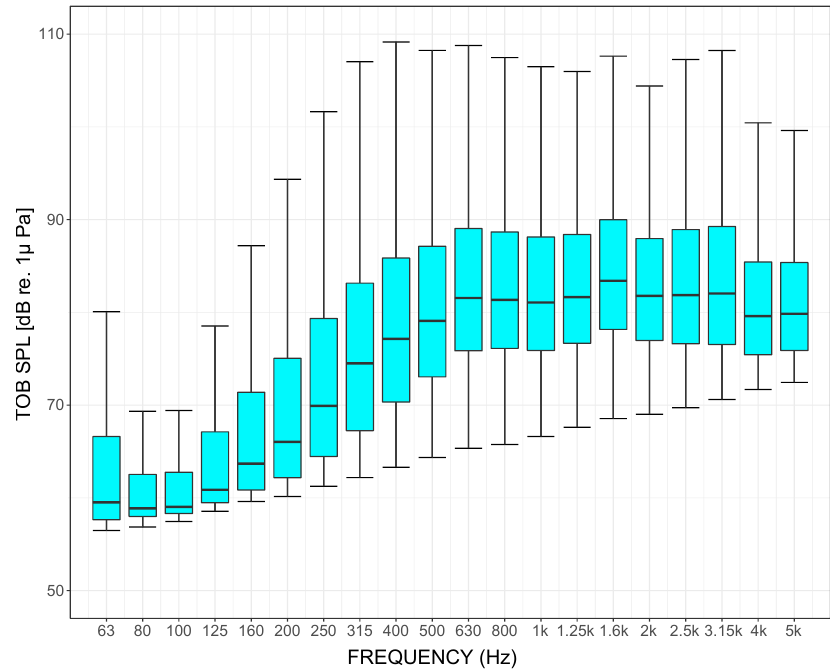
Figure 7. Boxplot of one-third of octave band (TOB) received level (RL) ship noise for the period July 2018 with outliers removed. The lower and upper hinges show the exceedance levels L75 and L25, while medians are shown by the middle lines. The upper and lower whiskers indicate the 1.5 times difference of exceedance levels L25 and